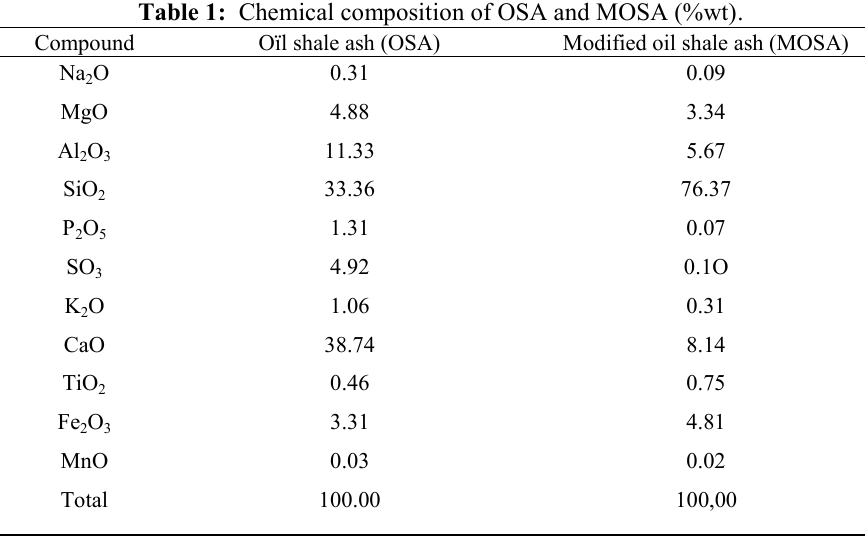
Table 1: Chemical composition of OSA and MOSA